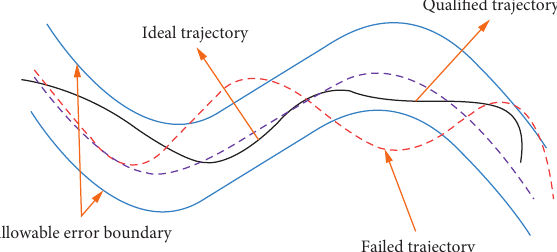
Figure 2: Difference of three